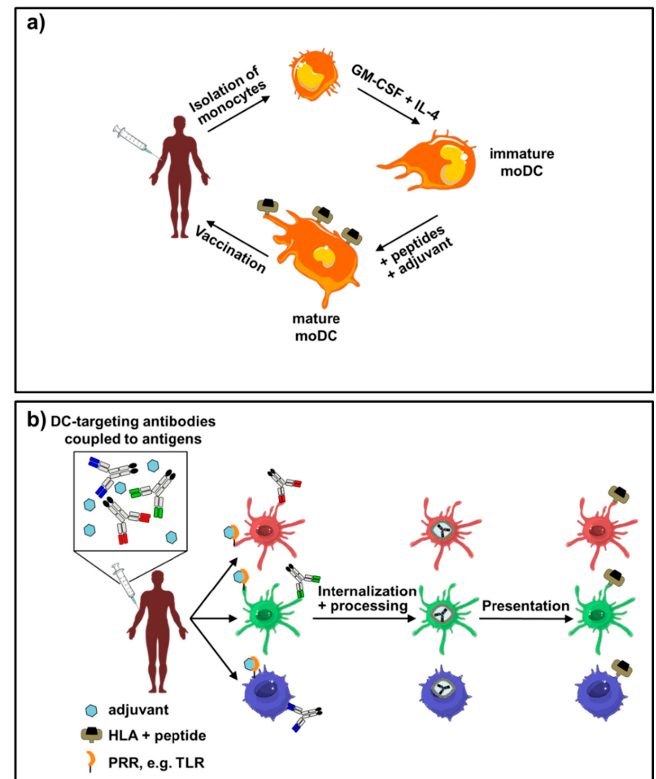
Figure 1. Principles of the use of human dendritic cells (DCs) for the treatment of diseases. There are two principal approaches to use DCs for the treatment of patients either by ( a ) using monocyte-derived DCs (moDCs) or by ( b ) directly targeting DCs in the patient using DC-targeting antibodies coupled to antigens. ( a ) For the vaccination of patients with their own moDCs, monocytes are isolated from the blood of the patient and differentiated into moDCs by culturing them in media containing GM-CSF and IL-4 for 5–6 days. Subsequently, cells are loaded with antigens and either matured with adjuvants (e.g., cytokine cocktail consisting of IL-1 β , IL-6, TNF α , and PGE 2 ) or kept immature. These cells presenting peptides of the antigen as peptide-MHC complexes on their surface are then transfused back into the patient to induce either an inflammatory T cell response (matured DCs) or tolerance (immature DCs); ( b ) in an alternative approach, antigens are targeted directly to DCs in vivo by fusion of the antigen to antibodies directed against DC surface molecules. After binding to the DCs, the antibodies are internalized, processed, and presented on MHC class I and II molecules on the DC surface. Analogous to moDCs, the DCs induce an inflammatory T cell response in the presence of adjuvants such as toll like receptor (TLR) ligands or tolerance, if the antibody is injected alone without adjuvant. By usage of antibodies directed against surface molecules selectively expressed on one DC subset (here differentially colored in red, green, and blue), the type of immune response can be further regulated due to different functions of the DC subsets. Templates from Servier Medical Art (www.servier.com) were used and adapted for this